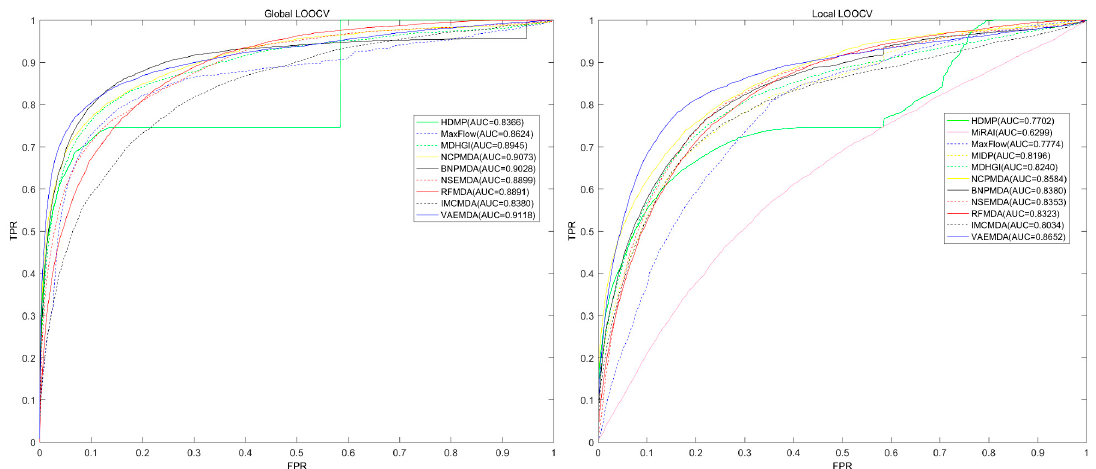
Figure 2. Performance comparison between VAEMDA and ten previous disease-miRNA association prediction models (NCPMDA, BNPMDA, MDHGI, NSEMDA, RFMDA, MaxFlow, IMCMDA, HDMP, MiRAI and MIDP) in terms of ROC curves and AUCs based on global and local LOOCV. As a result, VAEMDA outperformed other models by achieving an AUC of 0.9118 in global LOOCV and an AUC of 0.8652 in local LOOCV.